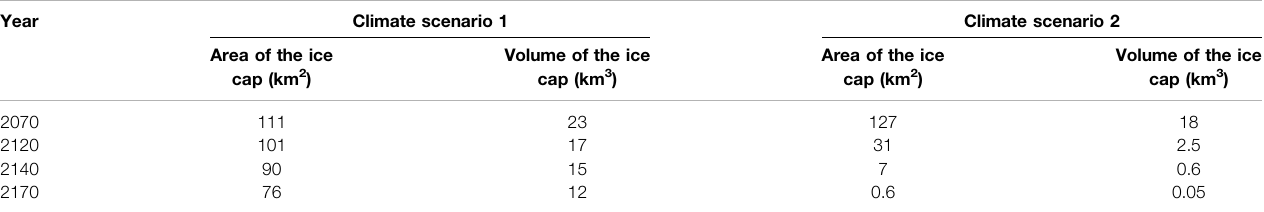
TABLE 3 | Decreasing glacial extent and volume of the Sørfonna ice cap for 4 years during climate scenarios 1 and